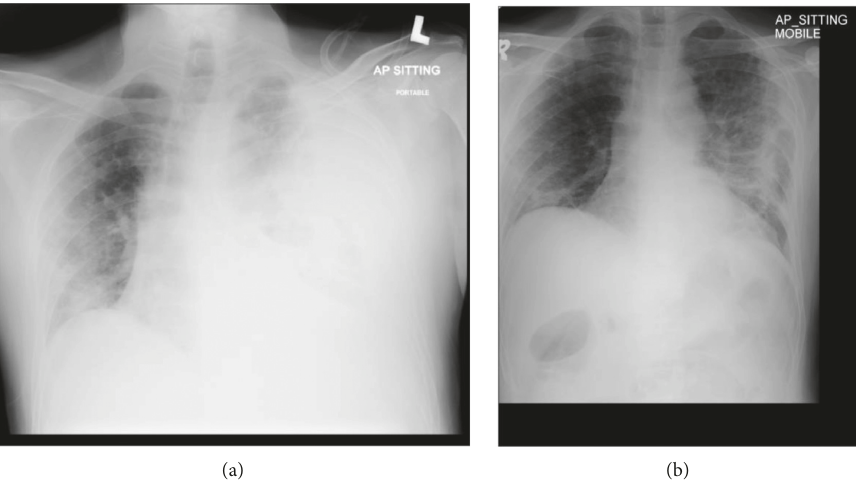
Figure 2: (a) A massive left sided pleural effusion with right mediastinal shift. (b) A marked improvement in left